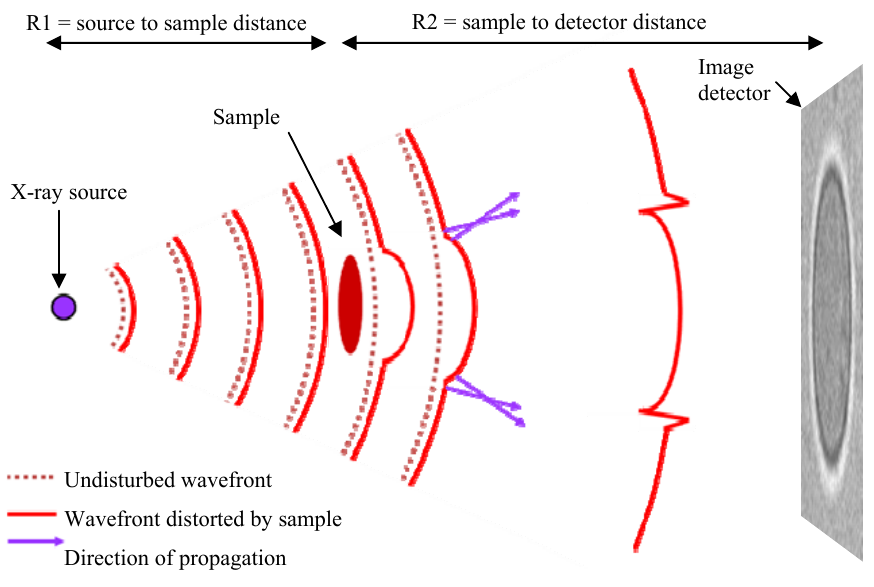
Figure 1. Mechanism of in-line phase-contrast: A sample imposes a phase-shift on the X-ray beam, which distorts the X-ray